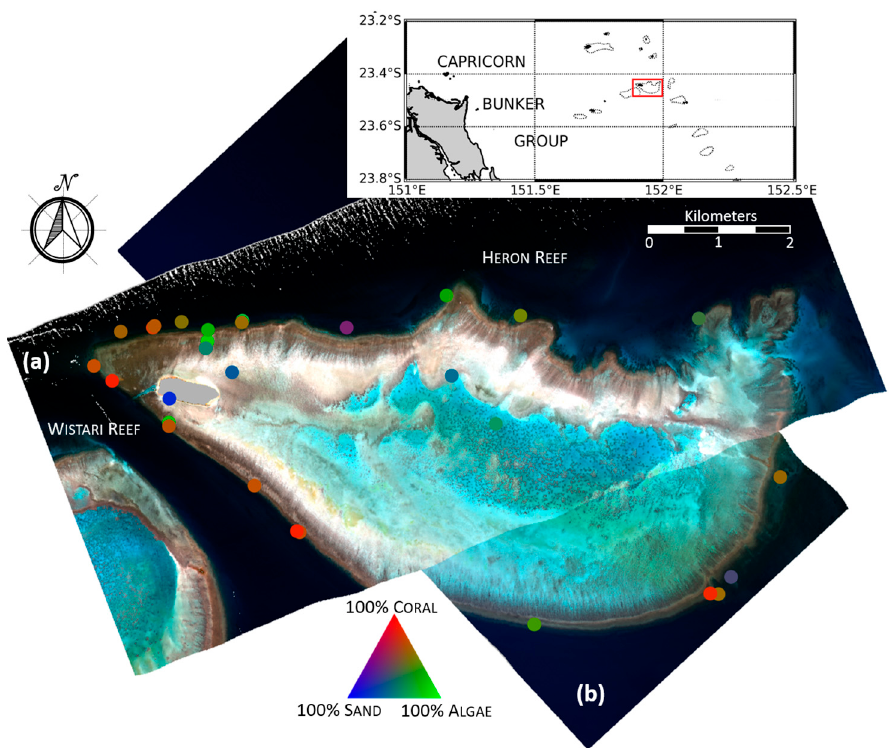
Figure 3 . Pseudo RGB image of two PRISM swaths of Heron Reef captured on ( a ) 00:10 h 17 September 2016 and; ( b ) 23:12 h 16 September 2016 UTC. Sunglint is evident on the northern edge of swath ( a ). The circles show the locations of the benthic mosaics. The RGB color of these circles represents the fractional coverage of Coral, Algae and Sand derived from the benthic photomosaics.